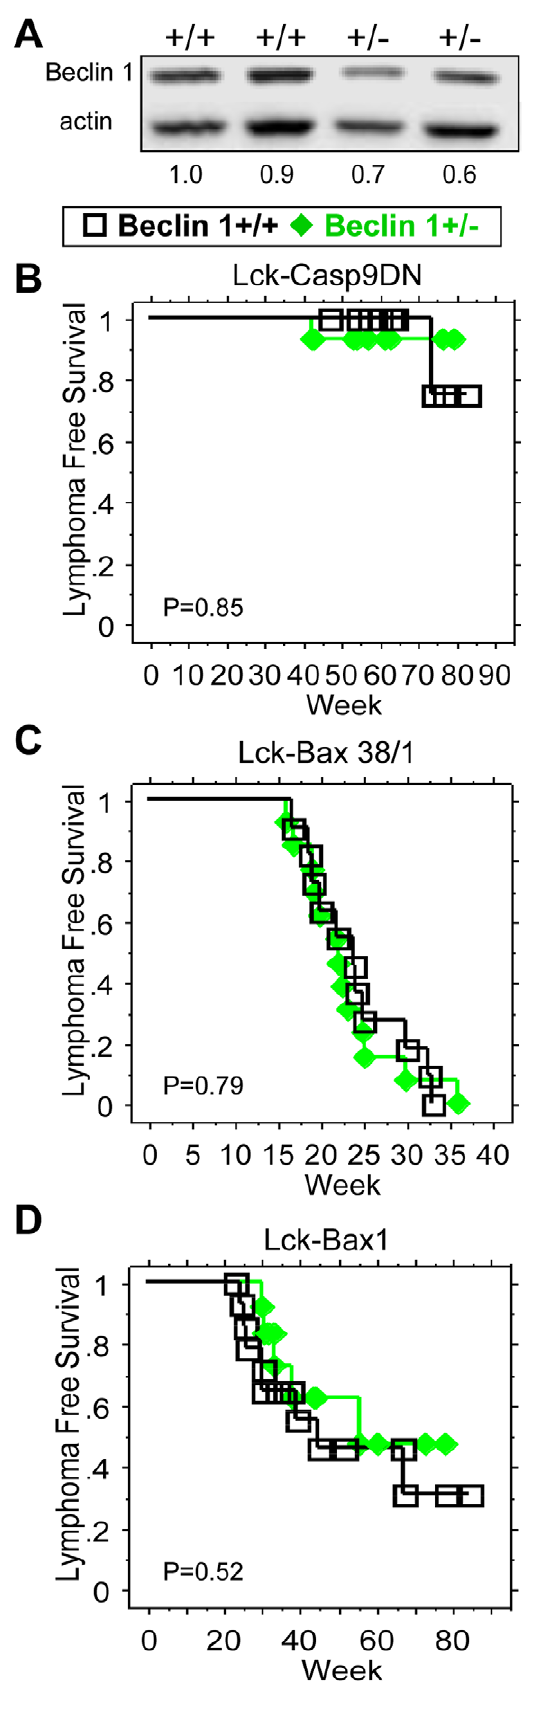
Figure 6. Beclin 1 + / 2 does not accelerate lymphoma formation. A ) Primary thymocytes were isolated from mice of the indicated genotypes. Immunoblots for Beclin 1, and actin as a loading control are shown. The ratio of Beclin 1 to actin for each mouse is shown below the immunoblots. Kaplan-Meier analysis for lymphoma free survival B ) comparing Beclin 1 + / + x Lck-Casp9DN (black open square, N=12) and Beclin 1 + / 2 x Lck-Casp9DN (green solid diamond, N=14) mice, C ) comparing Beclin 1 + / + x Lck-Bax38/1 (black open square, N=11) and Beclin 1 + / 2 x Lck-Bax38/1 (green solid diamond, N=13) mice, and D ) comparing Beclin 1 + / + x Lck-Bax1 (black open square, N=15) and Beclin 1 + / 2 x Lck-Bax1 (green solid diamond, N=12) mice is shown. Those mice were followed for lymphoma-free survival as described under materials and methods. P-value of analysis is